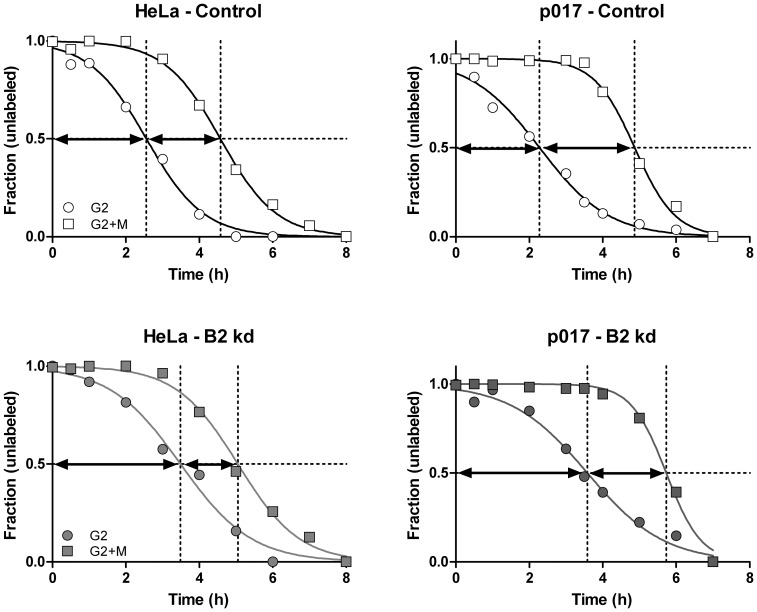
G2 and M phase transitions after cyclin B2 knockdown.HeLa or Dox treated p017-4 cells were transfected with control or cyclin B2 siRNA (B2 kd) for 18 hours, then continuously labeled with BrdU. Cells were then trypsinized, fixed, and immuno-stained for BrdU, PHH3, (and cyclin A2 in one experiment) and DNA content, then measured by flow cytometry. The frequencies of unlabeled G2 and M cells were quantified as previously described [37] and plotted versus time. The distance between the origin and the t1/2 point of the G2 curve (circles) = the average G2 time and the difference between the t1/2 of the M (squares) and G2 curves = the average M phase time. The values calculated from these data are presented in Table 2 (p017 and HeLa).